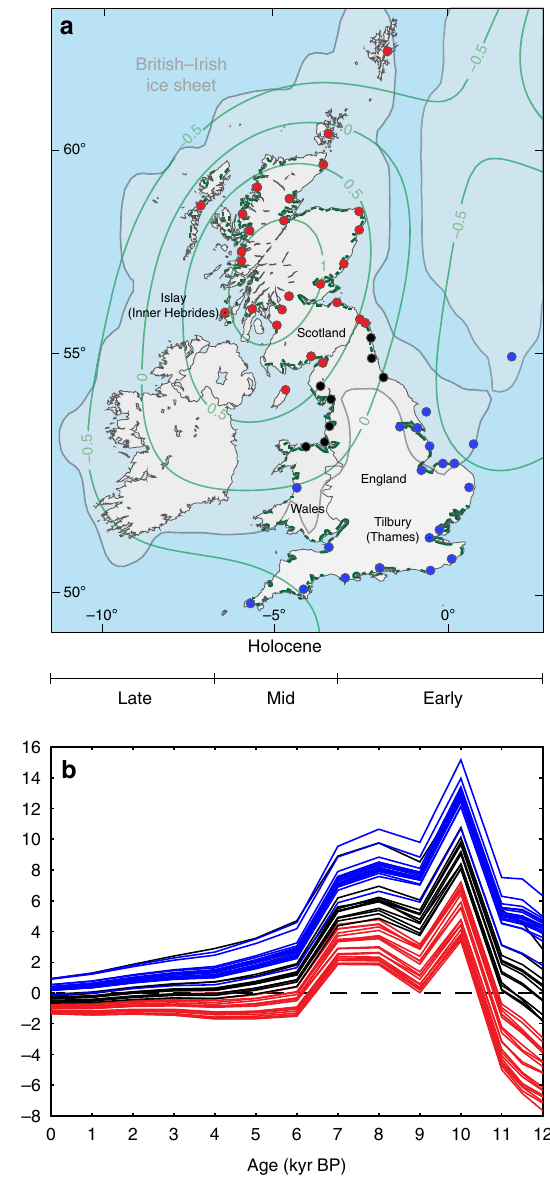
Fig. 1 The Great British Holocene relative sea-level database. a Location of the 54 regions used to group individual sea-level index points. Approximate spatial extent (in light blue) of the British – Irish ice sheet (BIIS) at the last glacial maximum (21,500 cal. yrs. BP), redrawn from ref. 19 (Copyright© 2011 John Wiley & Sons, Ltd). Contours represent the predicted present- day rate of land-level change, where relative uplift is positive, subsidence is negative (mm/yr) using the model from ref. 19 . Current areas of tidal marshes are shown (in green) following ref. 51 ; b Holocene rates of relative sea-level rise (RSLR) for 54 locations (Supplementary Table 3) of the Great British database of sea-level index points using the Bradley GIA model 19 (Methods). The red dots and lines are sites that are located close to the center of BIIS loading; black dots and lines are sites at the margin of the BIIS; and blue dots and lines are sites distal to the